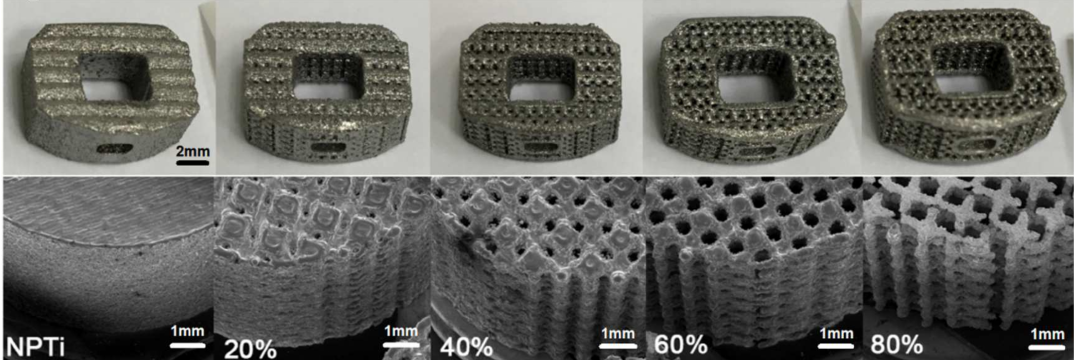
Figure 1. Additive-manufactured nonporous and porous cages (upper row, gross view; lower row, scanning electron microscopy 50 × ). NPTi, nonporous titanium cage; PTi, porous titanium